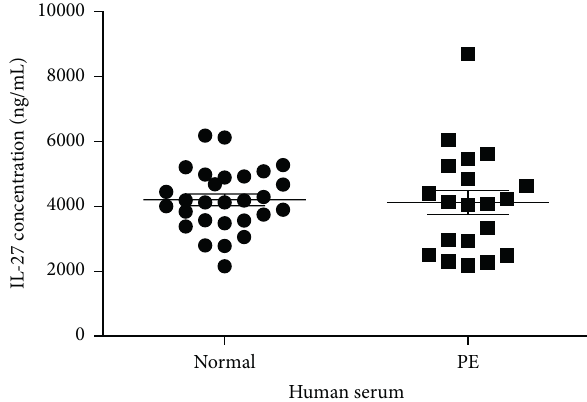
Figure 1: There is no significant variation in circulating IL-27 between normal and preeclamptic pregnancies. IL-27 was detected by ELISA in the serum from women with a diagnosis of preeclamp- sia ( 𝑛 = 20 ) and matched controls who had a normal pregnancy ( 𝑛 = 28 ). Blood samples were taken in the 3rd trimester of pregnancy. Bars represent median